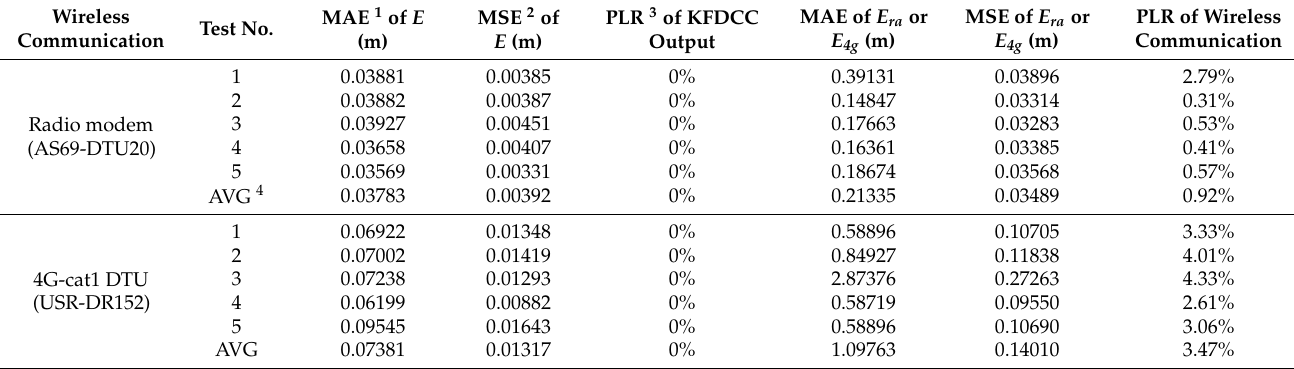
Table 4. Test results of algorithm accuracy evaluation.